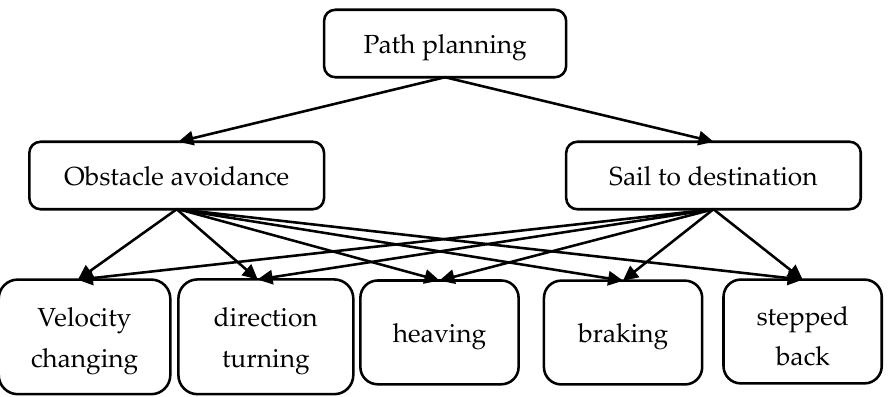
Figure 1. The hierarchy of motion planning.